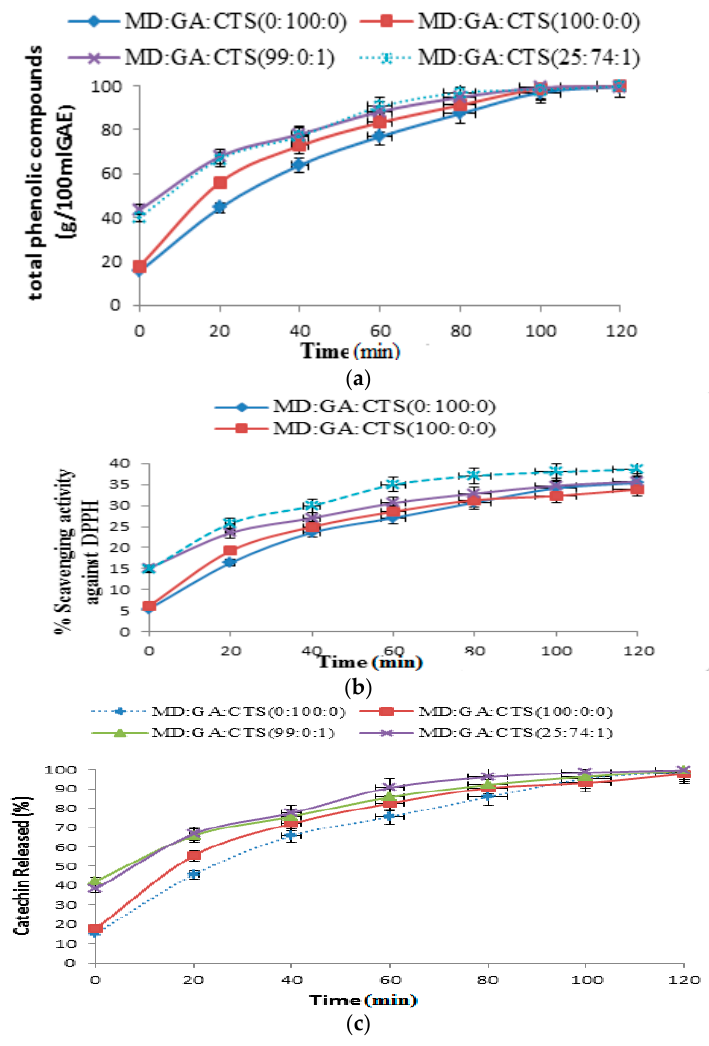
Figure 5. In vitro release profiles of ( a ) total phenolic content (TPC). ( b ) In vitro release DPPH scavenging activity; ( c ) In vitro release profiles of total catechins (TC) from microparticles in simulated gastric fluid (pH 2.3) at 37 ˝ C for 120 min. The values are represented as the means ˘ SD. (MD—maltodextrin, GA—gum arabic,